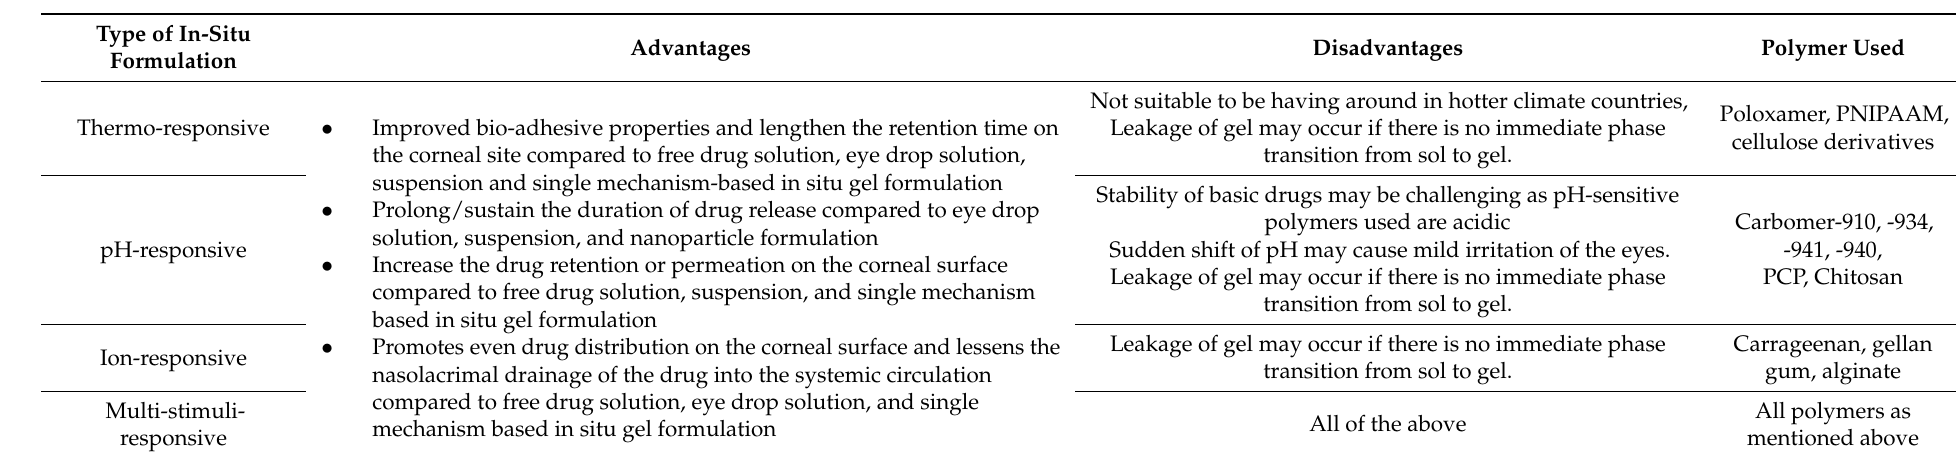
Table 5. Pros and cons of stimuli-responsive ocular in situ